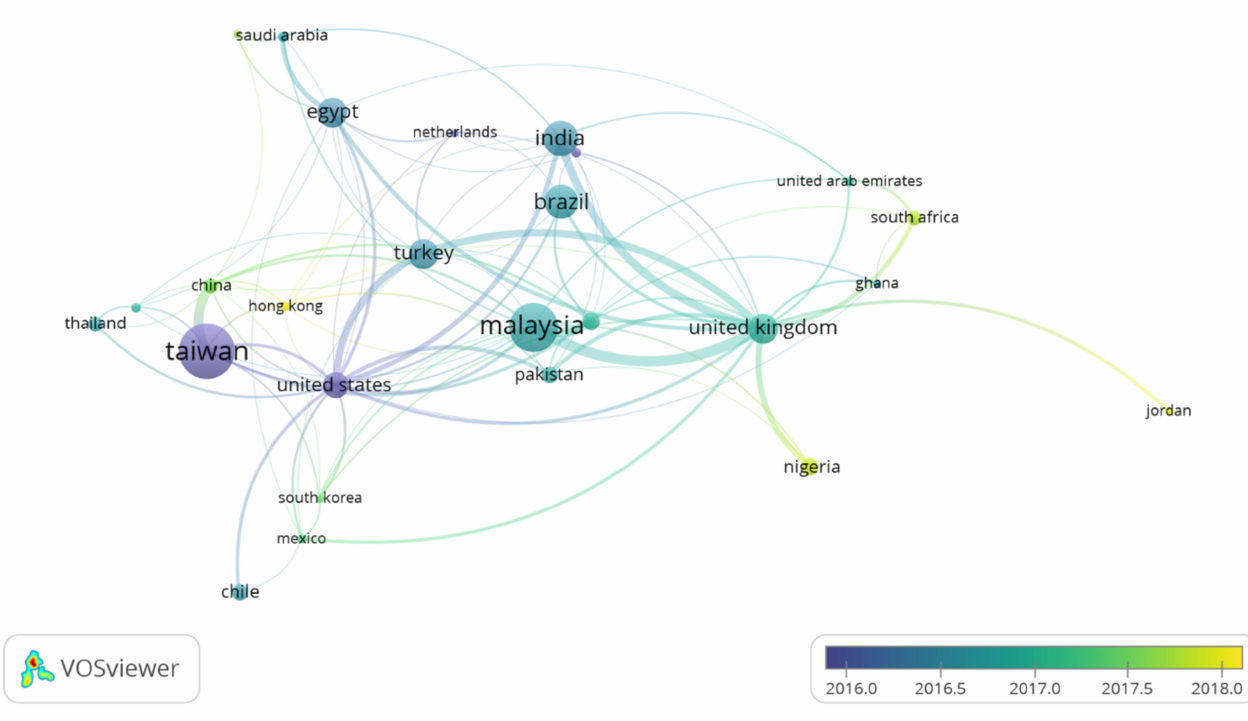
Figure 8. Country